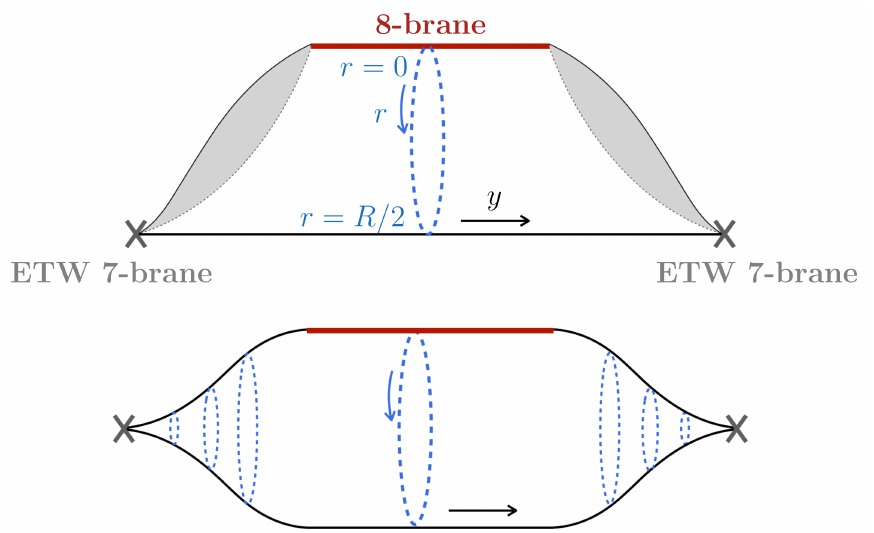
Figure 2 . Schematic view of the string frame